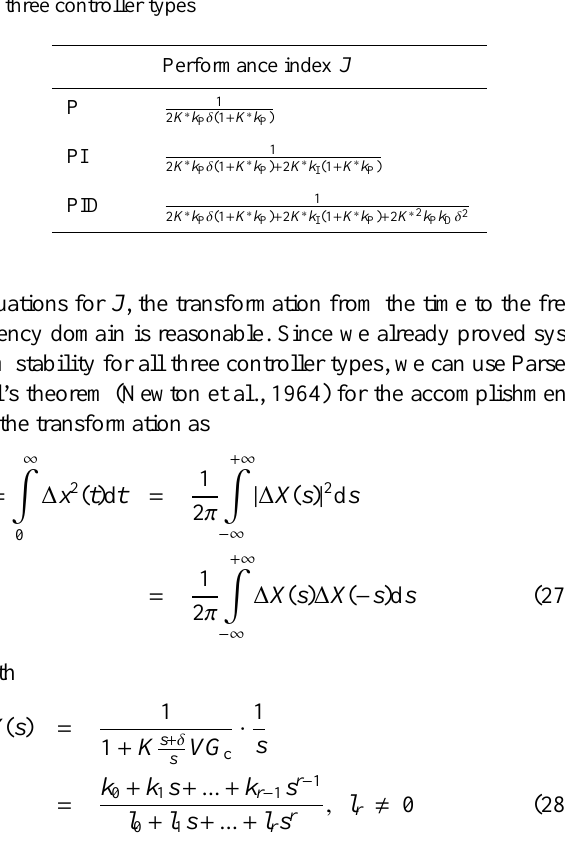
Table 9. Performance index from Eq. 27 for drift suppression for the three controller